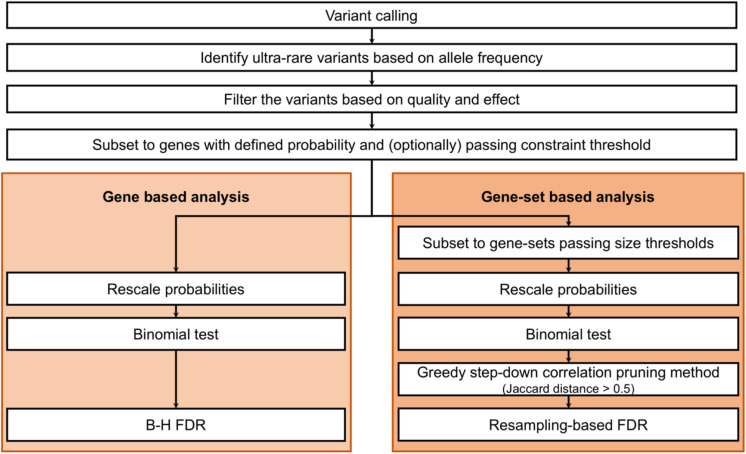
General gene and gene-set burden analyses overview.